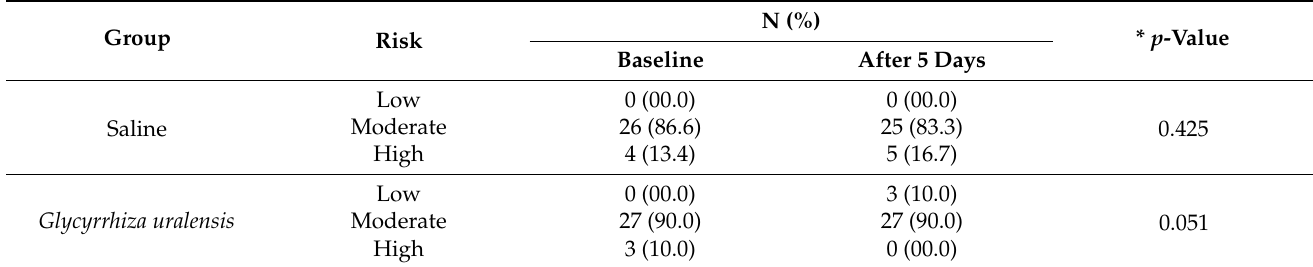
Table 4. Distribution of the subjects according to their risk differences ( n = 60).